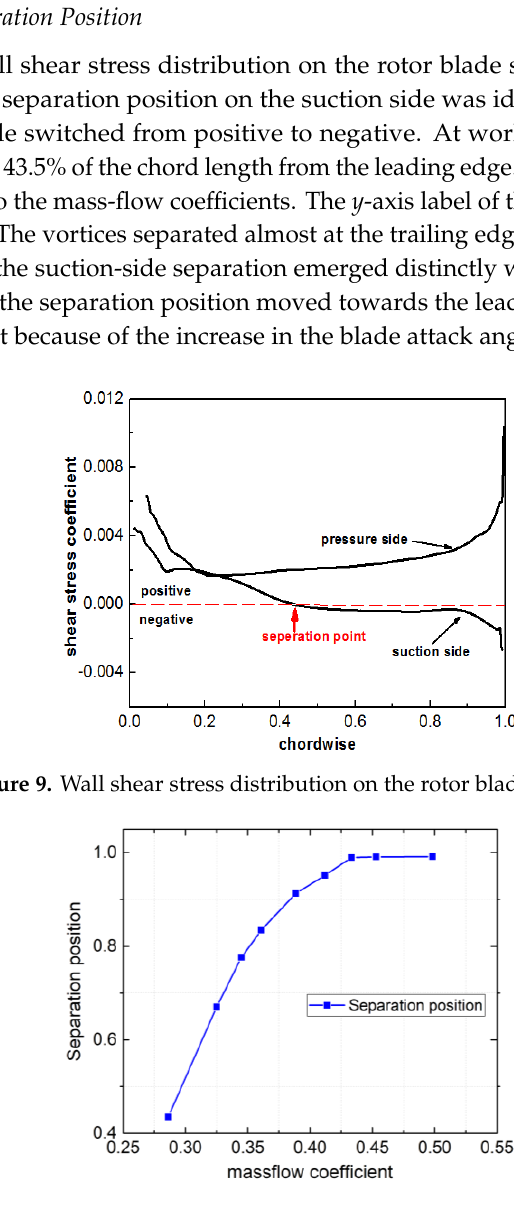
Figure 10. Variation of the separation position with mass flow.